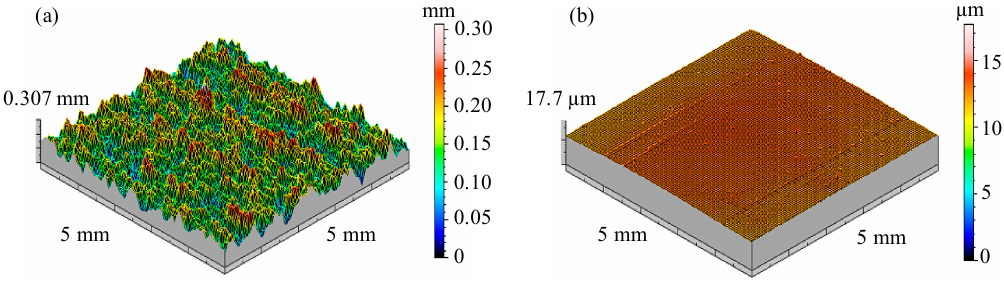
Figure 6. Representative surface profiles of the EBM Ti64 20 mm samples of ( a ) as-built and ( b ) as-polished.